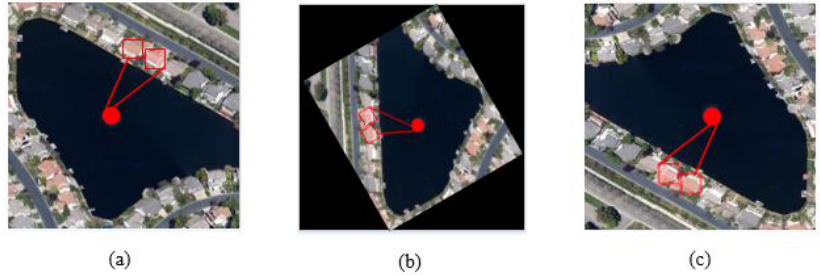
Figure 1. Angle between identical visual word pairs with respect to the centroid. Here ( a ) represents the original image, ( b ) the image rotated by 120 ◦ , and ( c ) the image rotated by 180 ◦